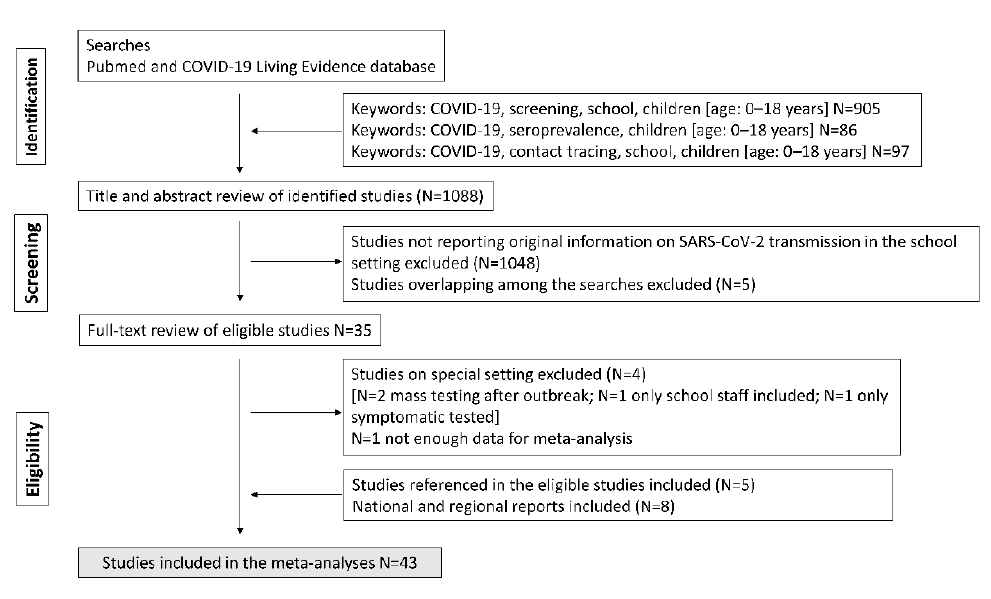
Figure 1. Flowchart of study .